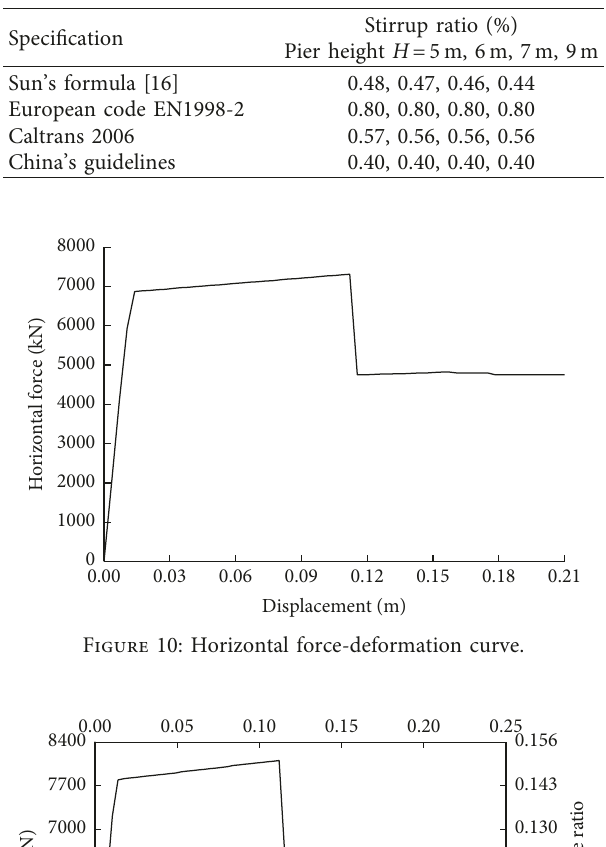
Table 6: Comparison of the stirrup mesh zones.